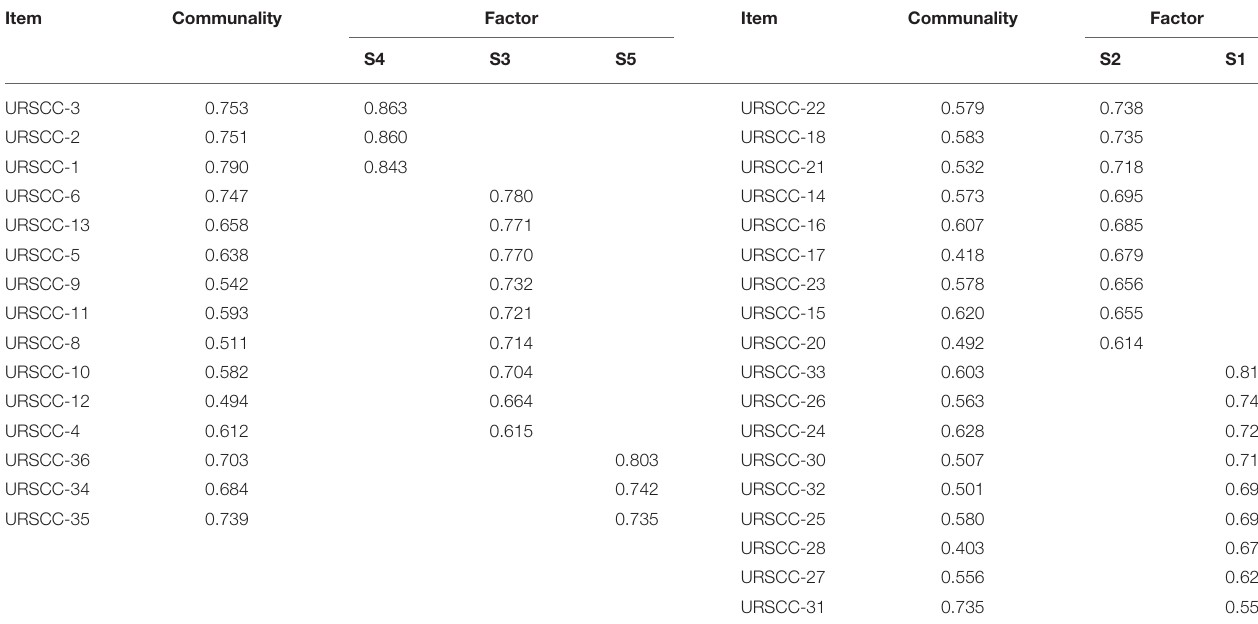
TABLE 5 | Exploratory factor analysis results.